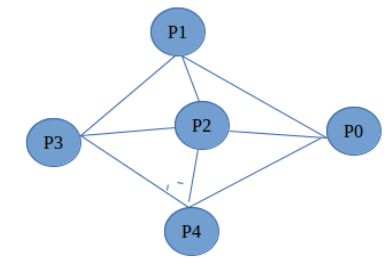
Figure 13. Exampleof a graph to calculate routingtables.